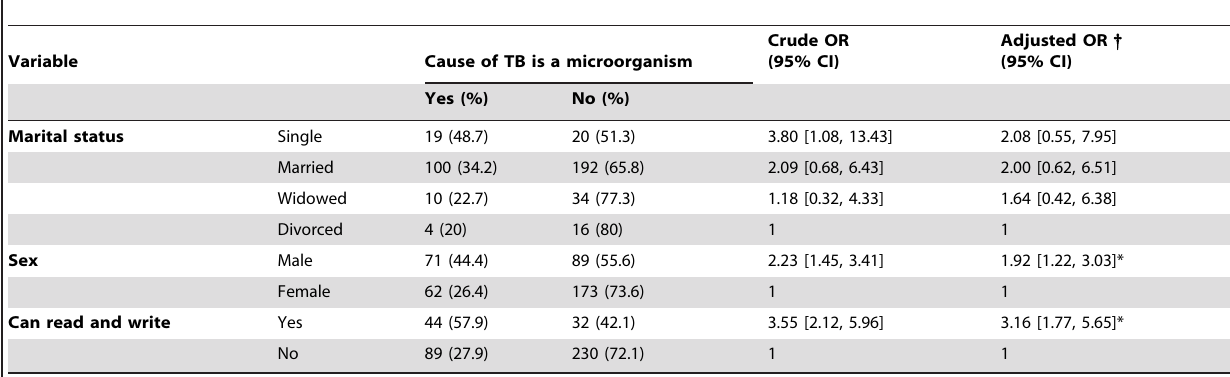
Table 3. Factors associated with knowledge about the cause of TB among TB suspects (n= 395) in the Gilgel Gibe field research area, south west Ethiopia, March